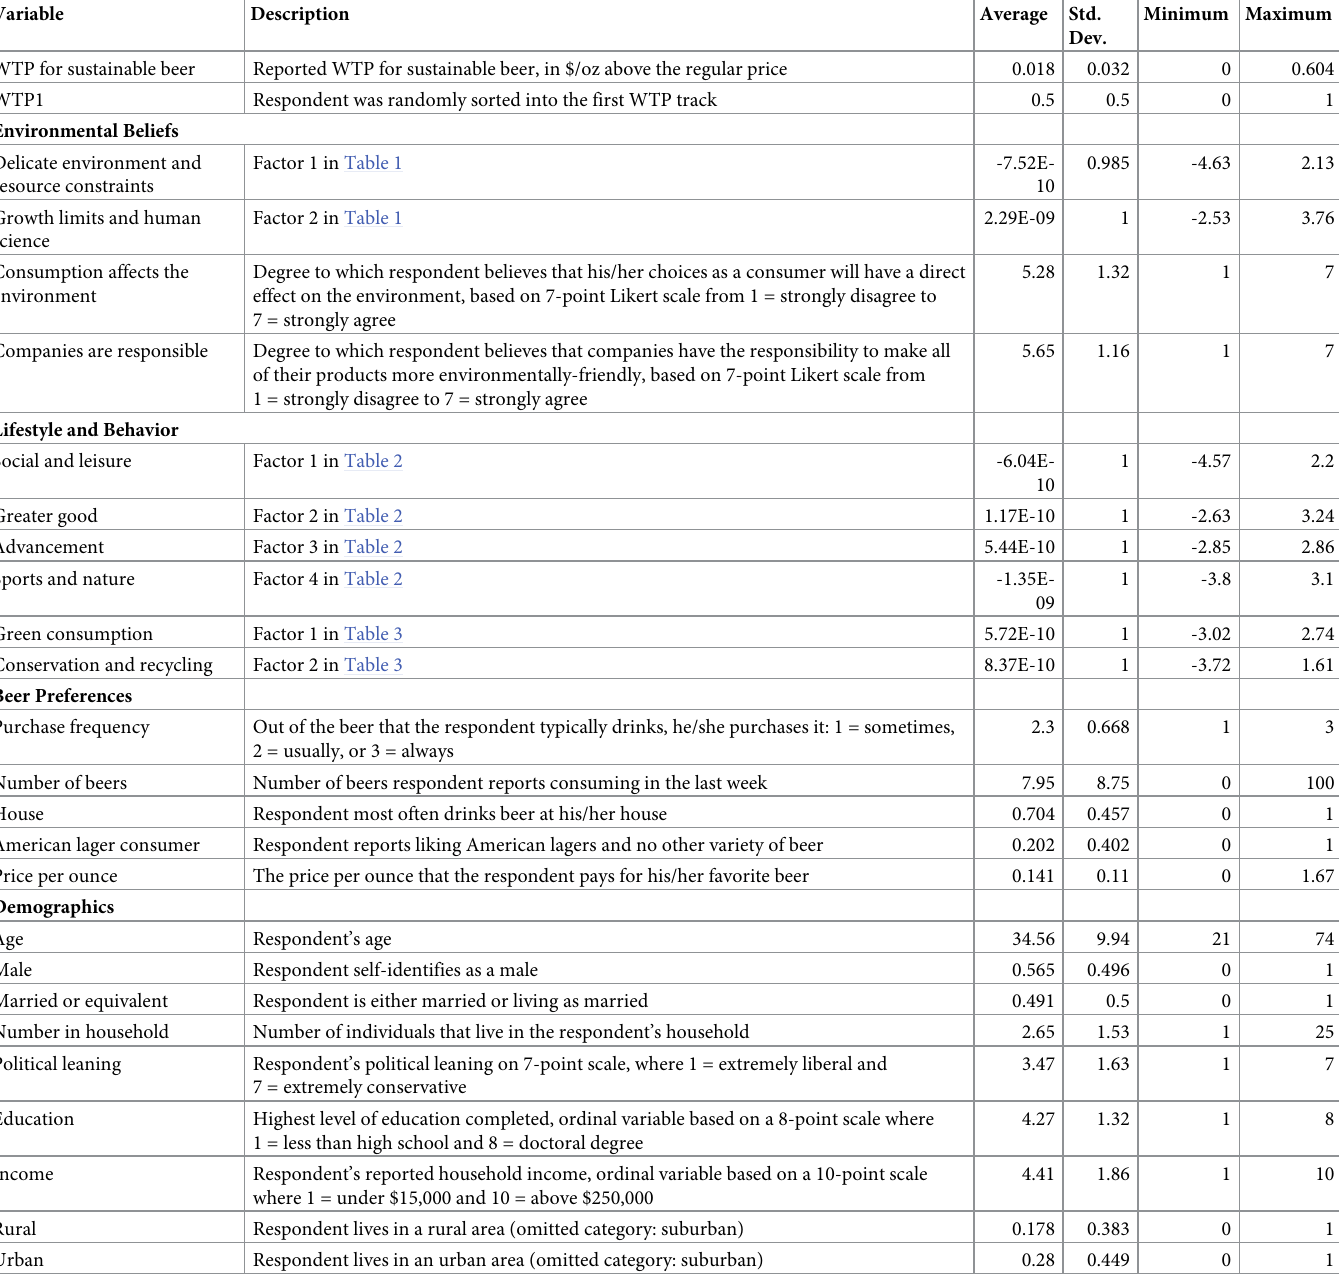
Table 4. Variable definitions and descriptive